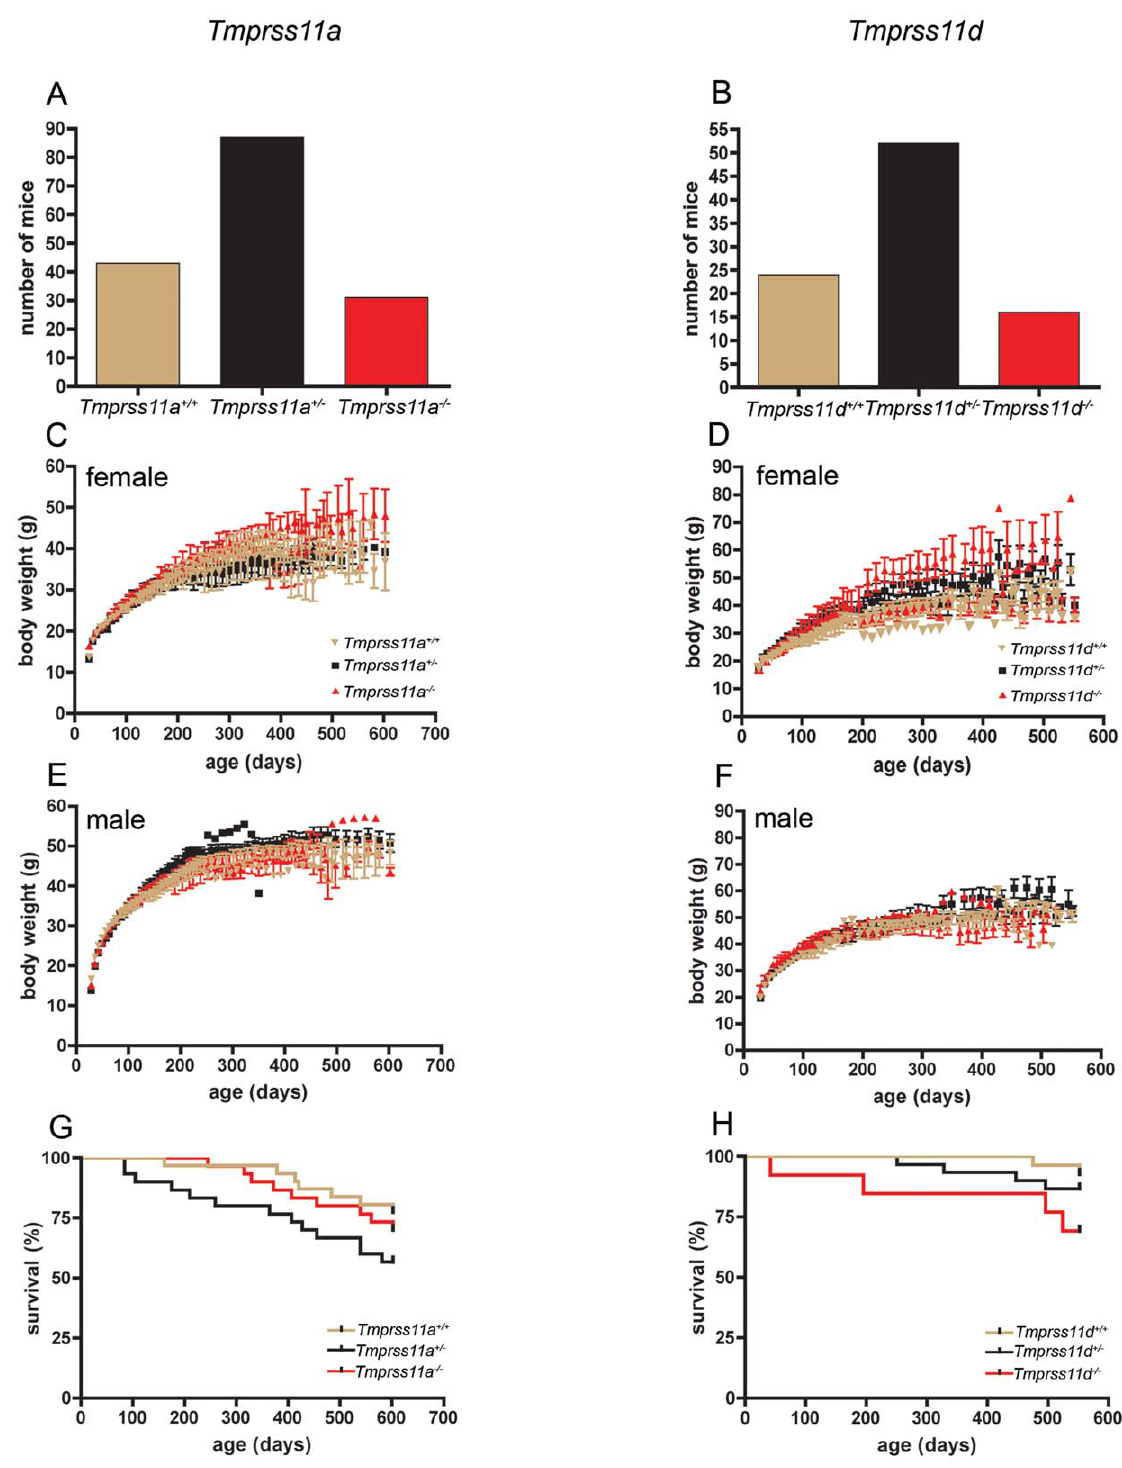
Figure 4. Development, growth, and survival of TMPRSS11A- and HAT-deficient mice. A and B. Genotype distribution of weaning-age offspring of interbred Tmprss11a + / 2 (A) and Tmprss11d + / 2 (B) mice. C–F. Post-weaning weight gain of cohorts of littermate Tmprss11a + / + (golden triangles, N=16), Tmprss11a + / 2 (black squares, N=15), and Tmprss11a 2 / 2 (red triangles, N=15) females (C), Tmprss11a + / + (golden triangles, N=15), Tmprss11a + / 2 (black squares, N=15), and Tmprss11a 2 / 2 (red triangles, N=15) males (E), Tmprss11d + / + (golden triangles, N=12), Tmprss11d + / 2 (black squares, N=15), and Tmprss11d 2 / 2 (red triangles, N=6) females (D), Tmprss11d + / + (golden triangles, N=15), Tmprss11d + / 2 (black squares, N=15), and Tmprss11d 2 / 2 (red triangles, N=7) males (F). G and H. Survival of prospective cohorts of littermate Tmprss11a + / + (golden lines, N=30), Tmprss11a + / 2 (black lines, N=30), and Tmprss11a 2 / 2 (red lines, N=30) mice (G) and Tmprss11d + / + (golden lines, N=27), Tmprss11a + / 2 (black lines, N=30), and Tmprss11a 2 / 2 (red lines, N=13) (H) mice that were followed for at least 500 days.